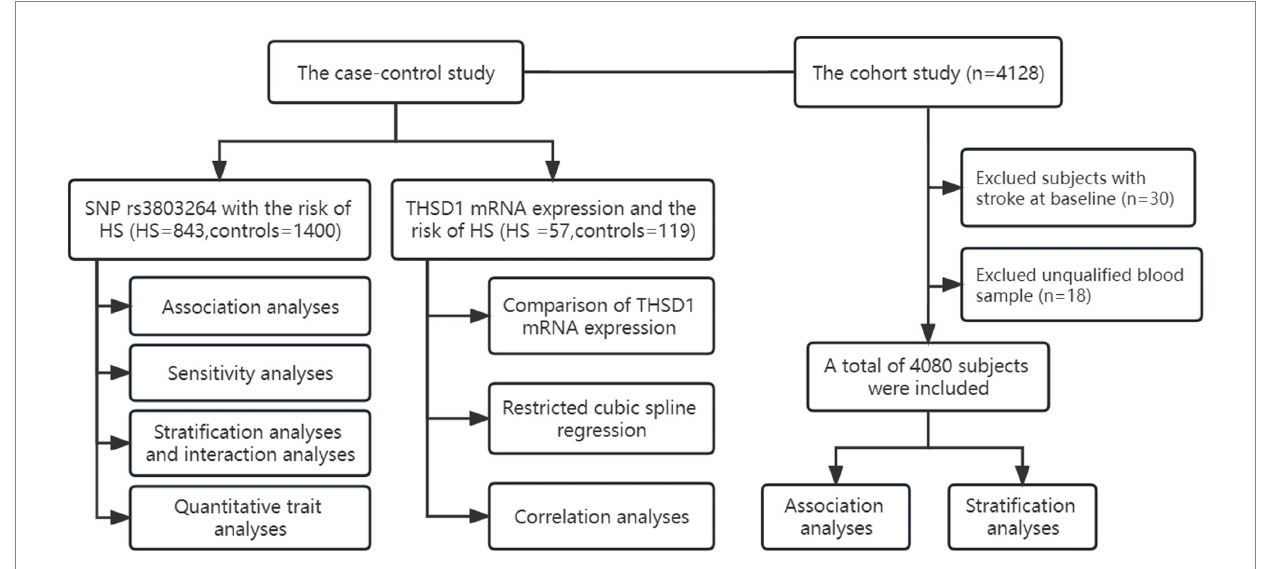
FIGURE 1 The flow chart of study design and statistical analyses. We conducted a case–control study and a cohort study to investigate the association of THSD1 genetic variants and mRNA expression with the risk of hemorrhage